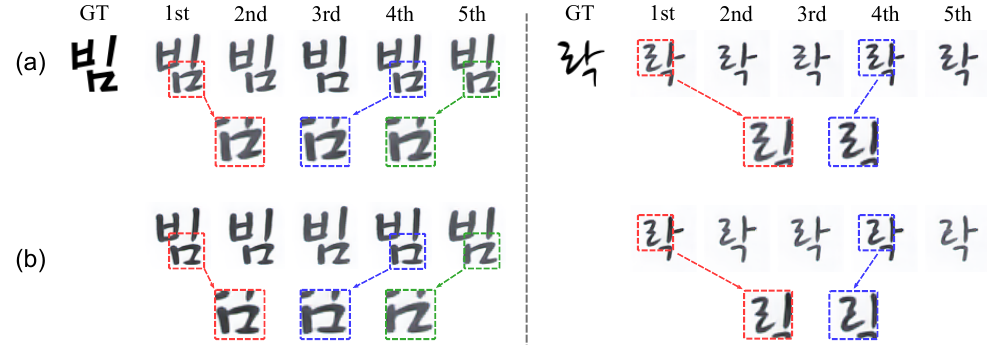
Figure 6. Examples of the generated font images for five trials with random combination of image in the stacked inputs. Each column on both sides of dashed vertical line shows the result with different combinations of stacked input for the same text content and font style: ( a ) w L consistency , ( b ) wo L consistency